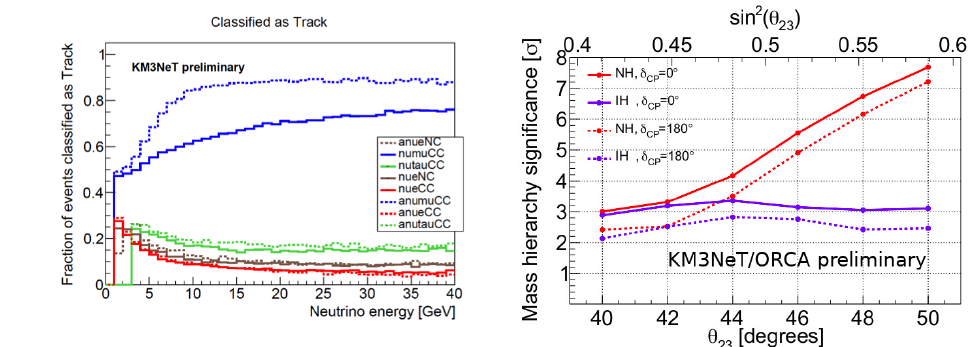
Figure 3. Fraction of events classified as tracks with the ORCA detector (left) and detector sensitivity to reject the wrong hierarchy after 3 years of data taking (right).